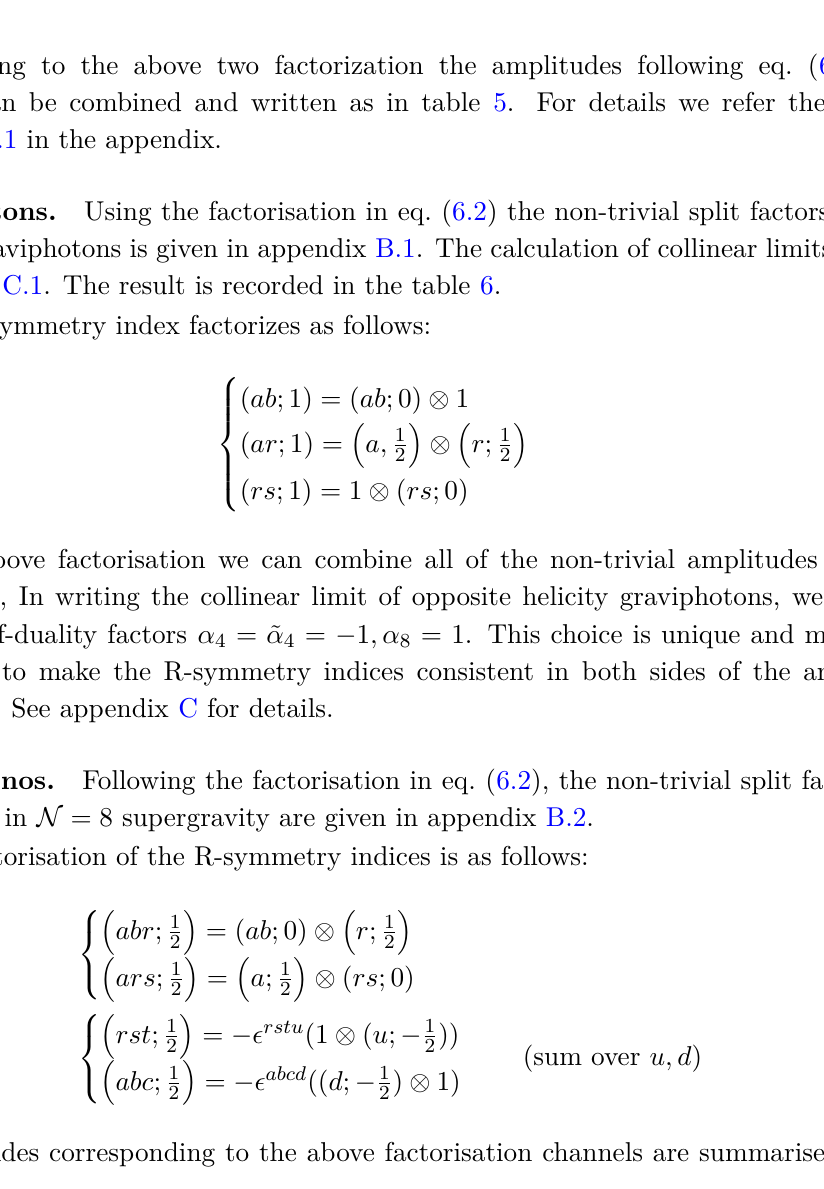
Table 6 . Amplitude corresponding to two collinear